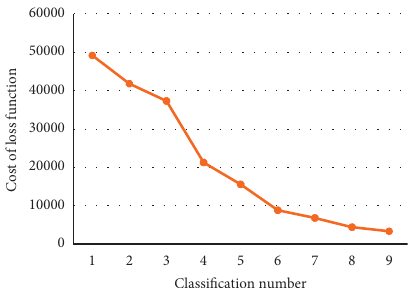
Figure 13: Loss function value of different classification